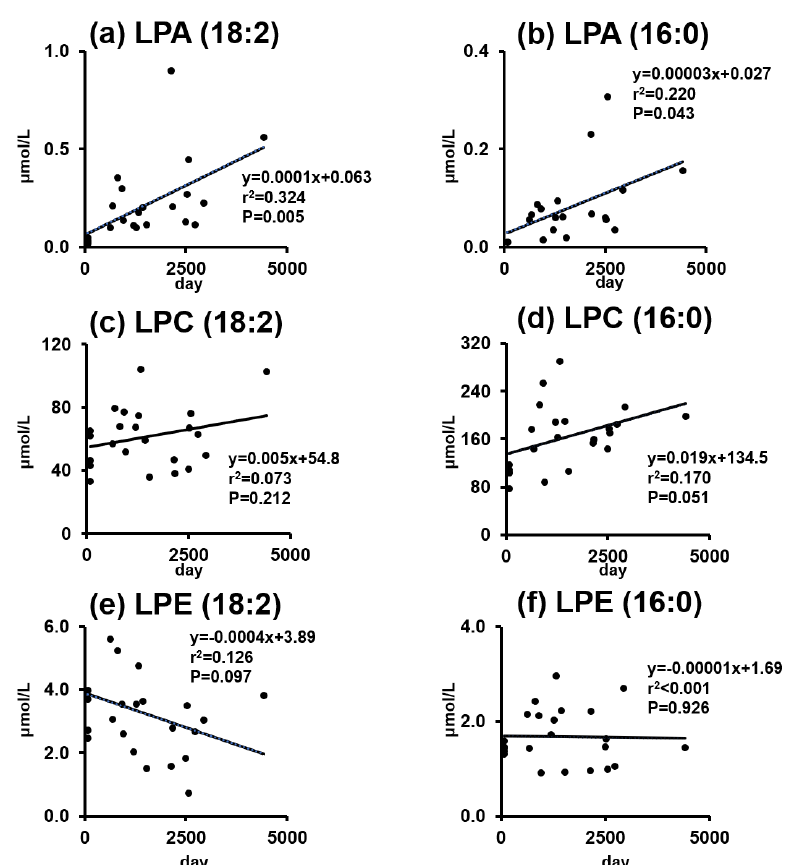
Figure 2. Regression analysis of the individual lysophospholipid species as a function of the duration of storage time in the control samples. The contents of LPA(18:2) and LPA(16:0) were significantly increased as a function of storage times ( a , b ), whereas the contents of LPC(18:2), LPC(16:0), LPE(18:2), and LPE(16:0) were not significantly changed ( c – f ).